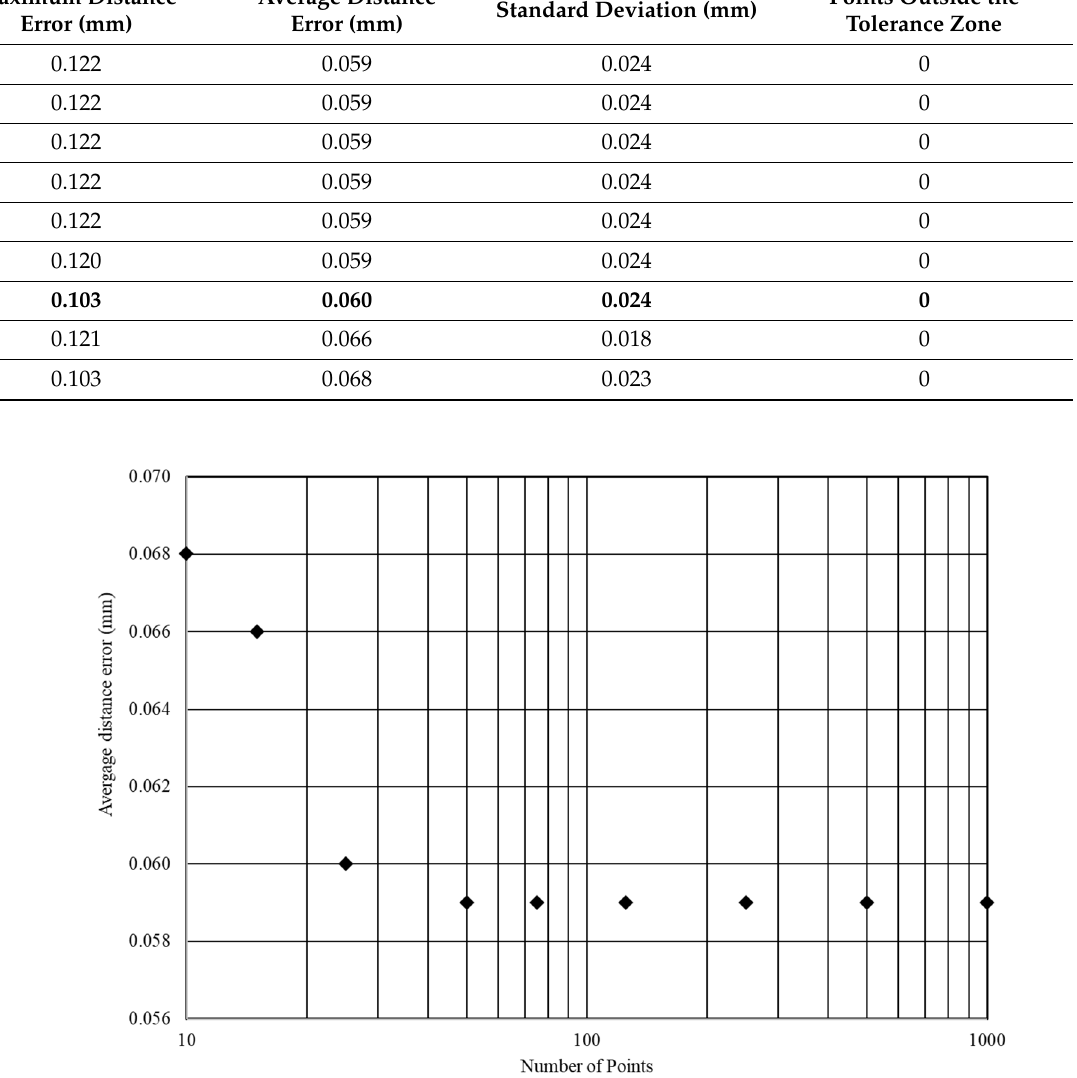
Figure 11. Average distance error between 10 and 1000 control points based on real CMM measurements for a part without defects.